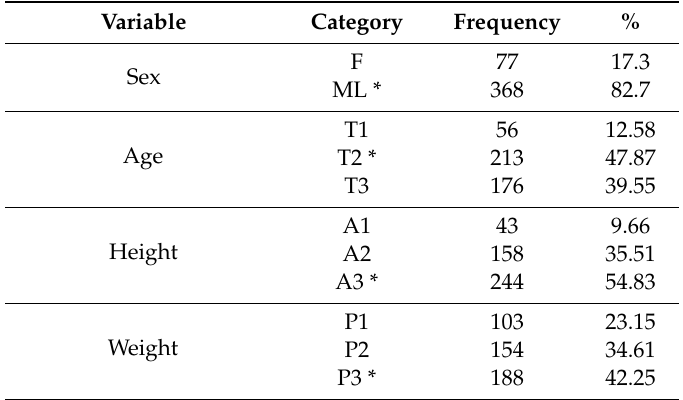
Table 4. Frequency and mode for the di ff erent categories of the qualitative